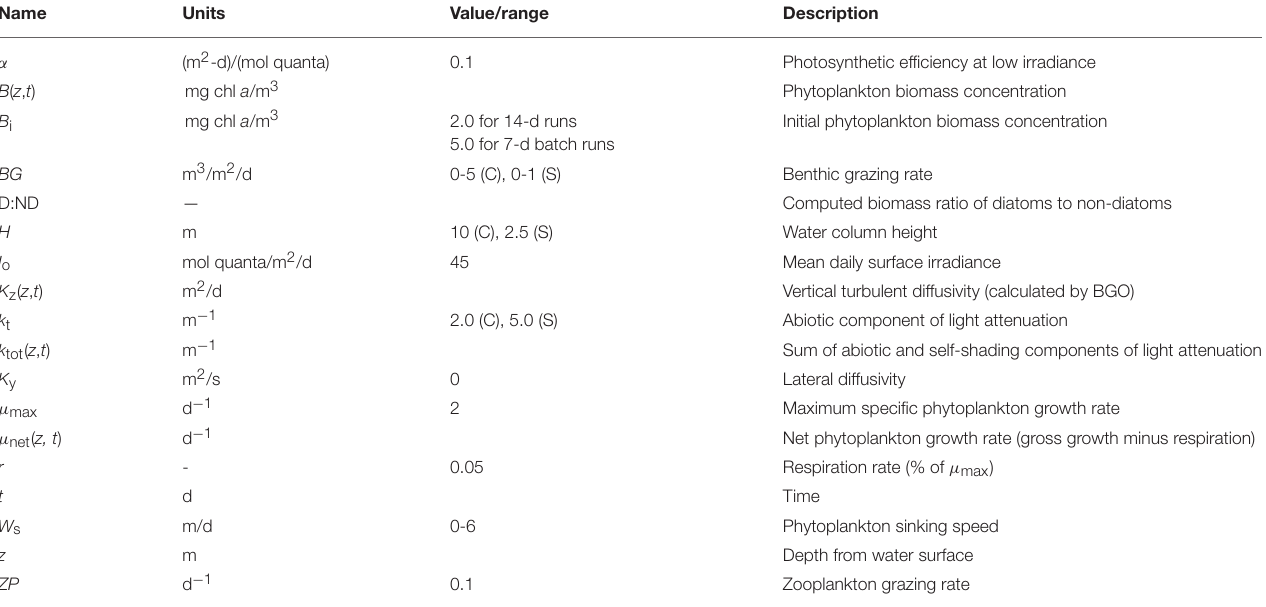
TABLE 1 | Model variables and constants used in PS2D simulations of generic channel and